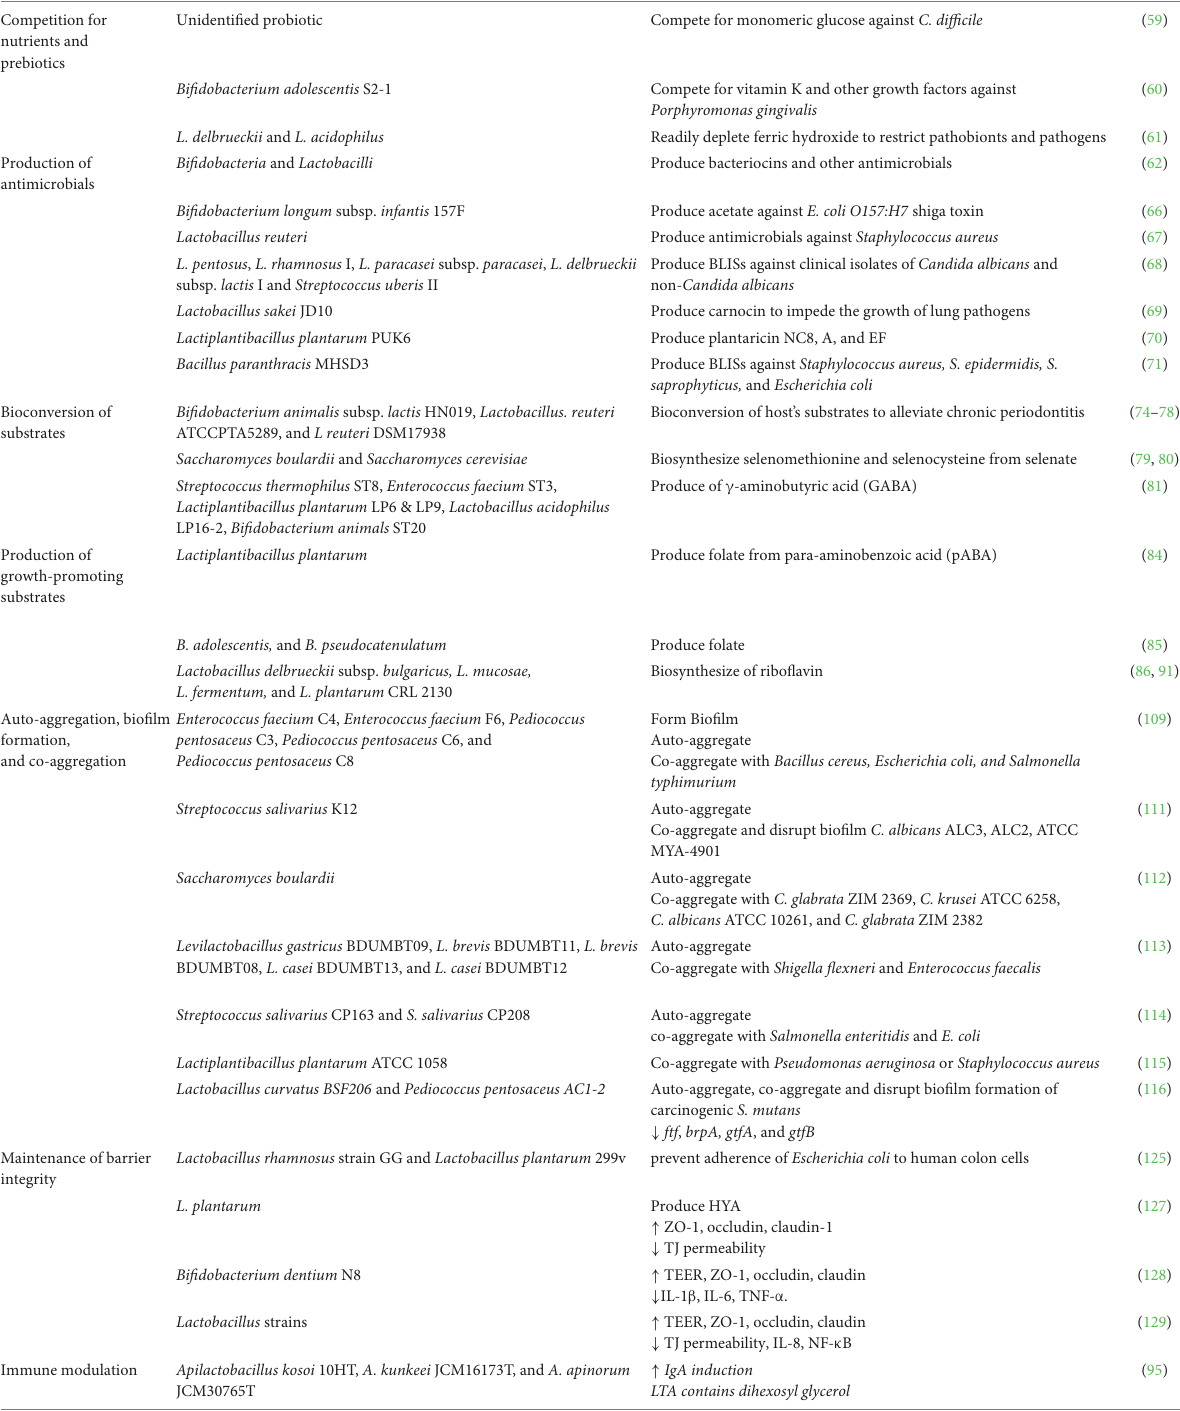
TABLE 1 Summary of probiotics-mediated molecular mechanisms that promote